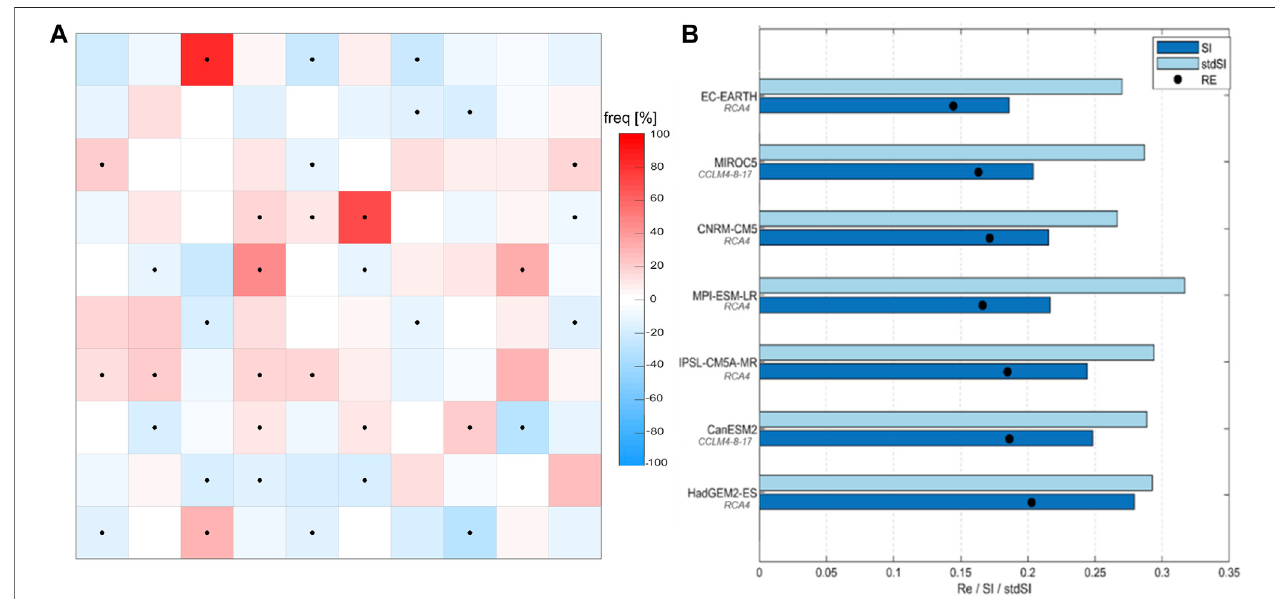
FIGURE 8 | Frequency discrepancies (FD) between the ensemble of the regional climate simulations and the ERA5 reference pattern (A) . Black dots stand for robustness of FD between model simulations. SI, RE, and stdSI metrics of each of the seven regional climate simulations analyzed (B) .